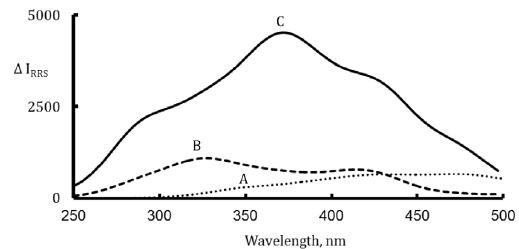
Figure 3: RRS spectra at pH 3.5: (A) for 3.0 µg/mL cyclobenzaprine, (B) for eosin Y (2.96 ´ 10 - 6 M), (C) for the reaction product between eosin Y and cyclobenzaprine (1.5